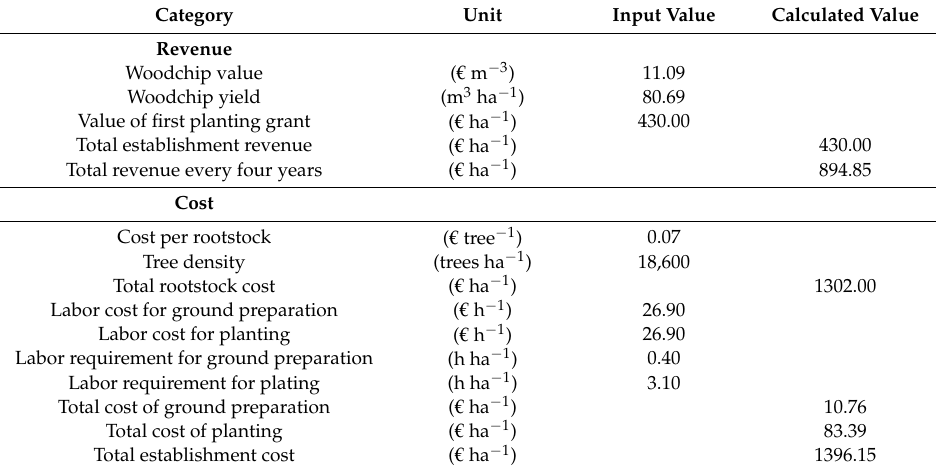
Table 1. Production costs and revenues from one hectare of sole short rotation woody crop (SRWC) production over a four-year